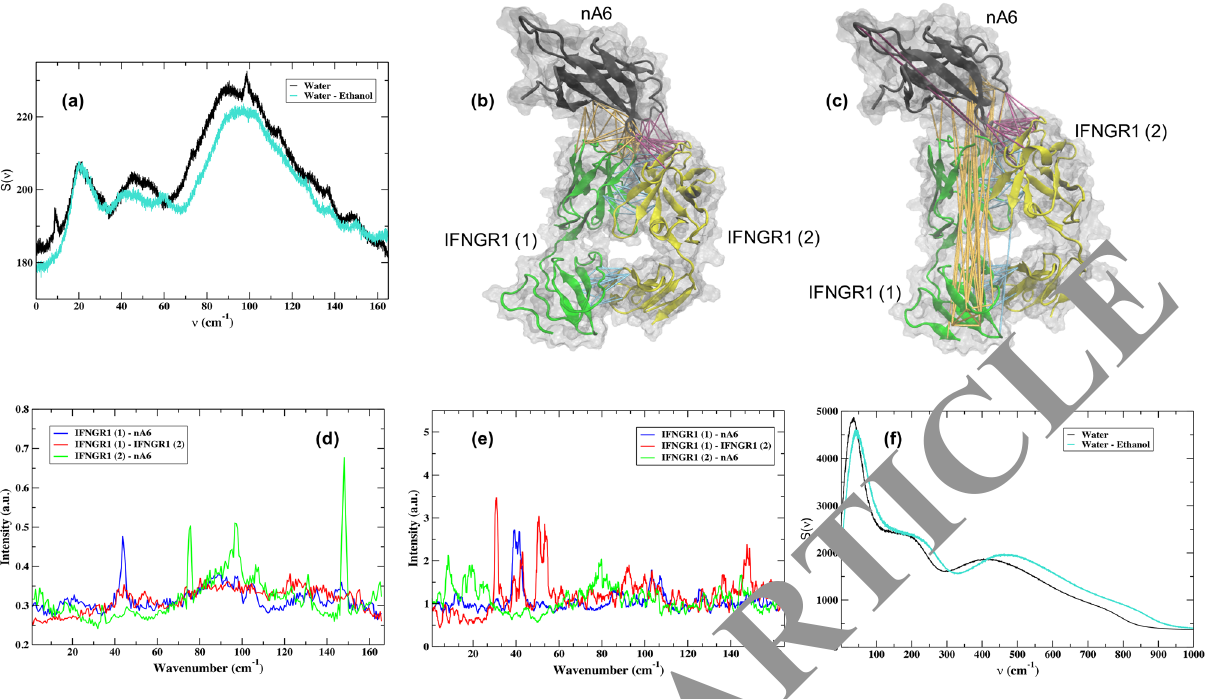
Figure 15. ( a ) The calculated VDOS of protein residues in the nA6 complex with a pure water hydration shell (black) and with a mixed water–ethanol hydration shell (cyan) from the MD simulation. A 3-D cartoon representation of the nA6 complex in ( b ) water and ( c ) in the water–ethanol solvent where the strain propagation from the force distribution analysis (FDA) is represented as colored links. The force between nA6 and IFNGR1 (1) is depicted by orange links, the force between nA6 and IFNGR1 (2) by magenta links, and the force between IFNGR1 (1) and IFNGR1 (2) is represented by cyan links in the 3-D structure. The calculated vibrational spectrum of the displacement of the correlated cluster of amino acids identified from the FDA of the components making up the complex in water ( d ) and ( e ) in the ethanol–water solvent. ( f ) The calculated VDOS of water in the nA6 complex with a pure water hydration shell (black) and with a mixed water–ethanol hydration shell